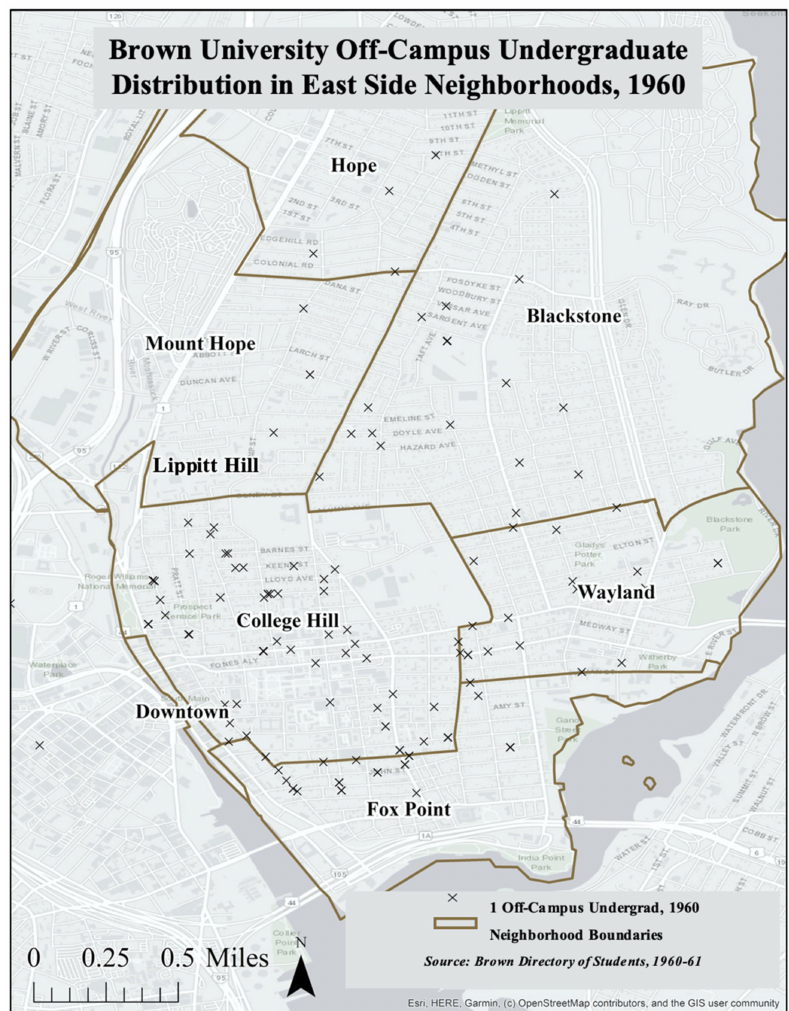
Figure 4. Brown University O ff -Campus Undergraduate Distribution in East Side Neighborhoods,